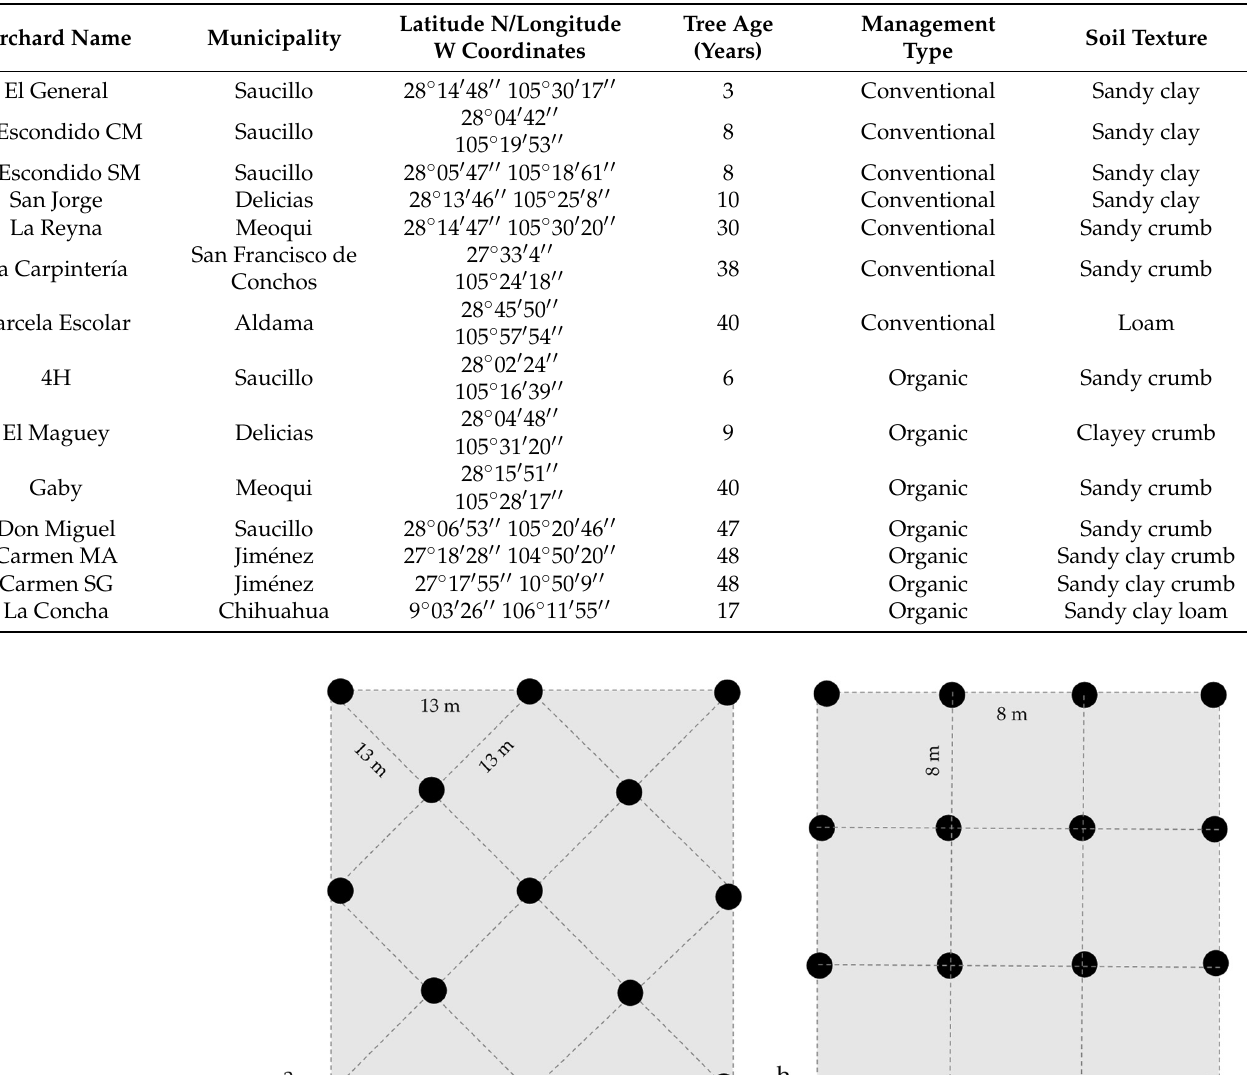
Table 1. The Western Schley pecan orchards [ Carya illinoinensis (Wangeh) K. Koch] with different agronomic management methods and ages in Chihuahua, Mexico, included in this study.